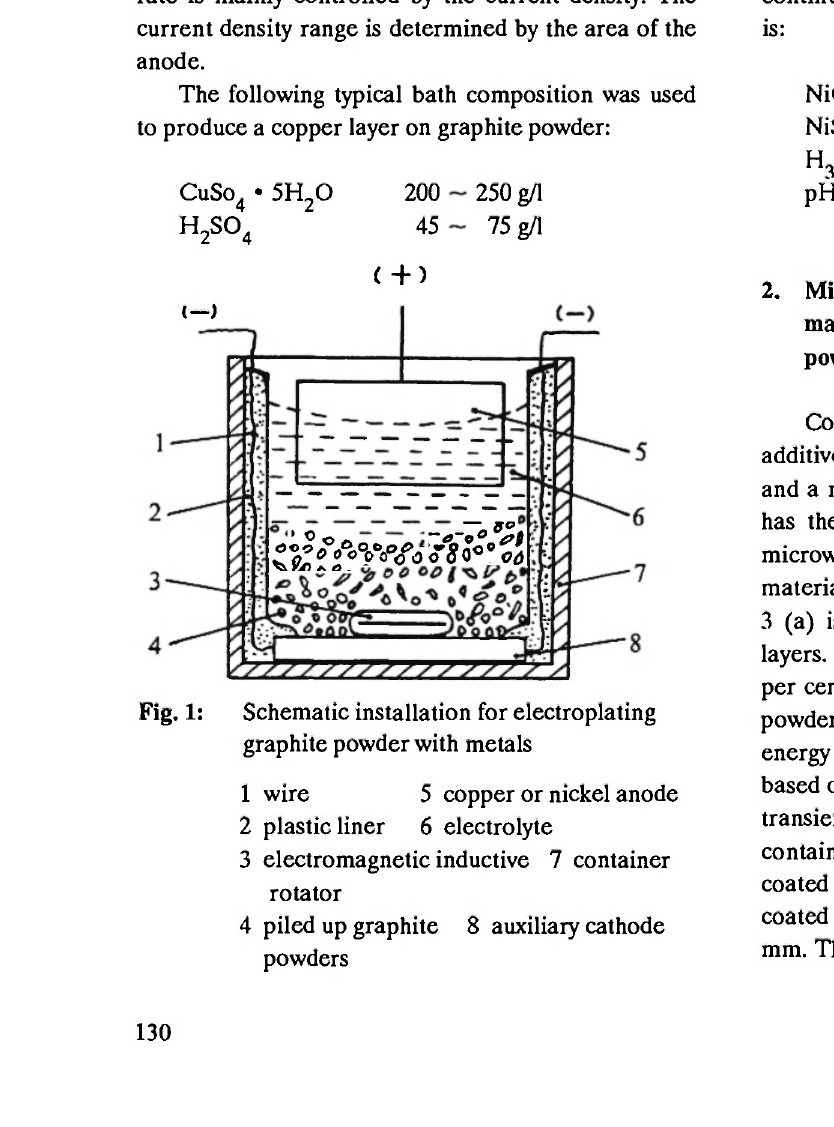
Fig. 2: Cross-section of copper layer on graphite